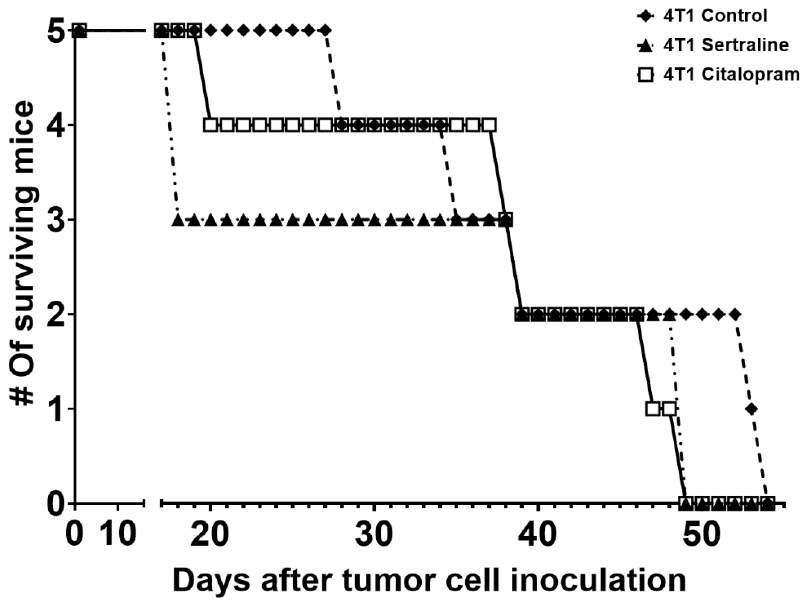
Figure 6. Survival of 4T1 cell grafted mice — Mice were treated with sertraline or citalopram (10 mg/kg/d each) and monitored up to day 52 after grafting, when the last mouse died due to tumor mass formation. Each group consisted of five mice.